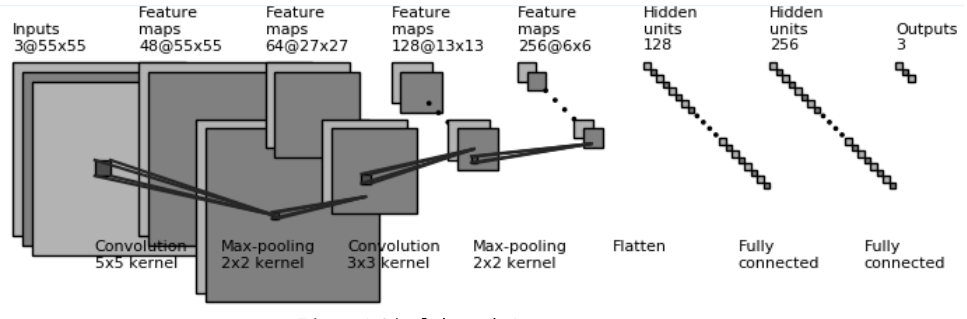
Figure 2 Single branch CNN structure